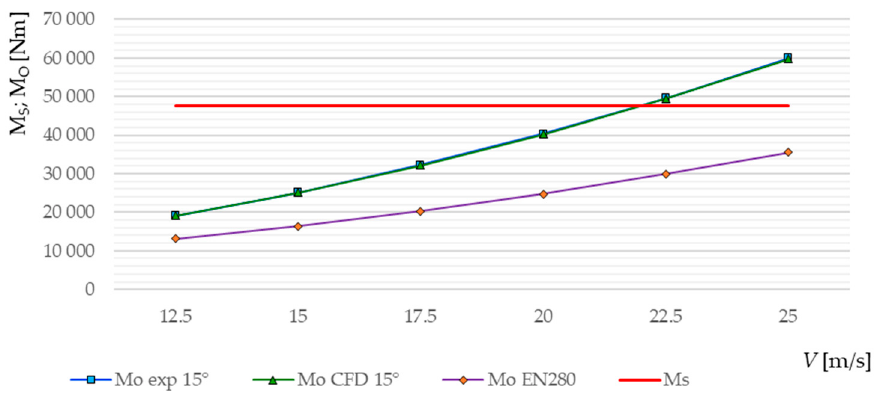
Figure 17. Comparison of the overturning and stabilizing moments received from the experimental and numerical tests for 15° angle of wind attack with the calculation based on standard EN280 for the wind speed V = 12.5–25 m/s.